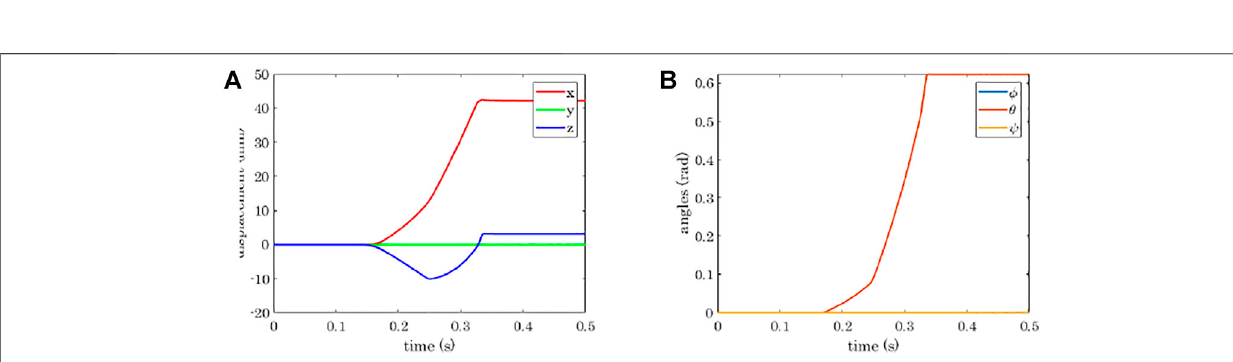
FIGURE 10 | Power grasp of a sphere with the four- fi ngered gripper: temporal sequence of the closing motion (A) , contact detection on the palm (B) .